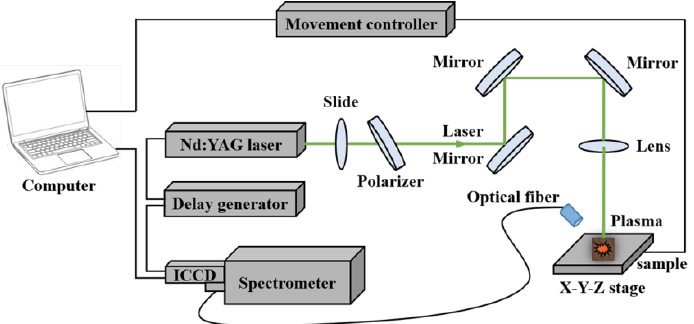
Figure 1. The schematic diagram of the laser-induced breakdown spectroscopy (LIBS) system.